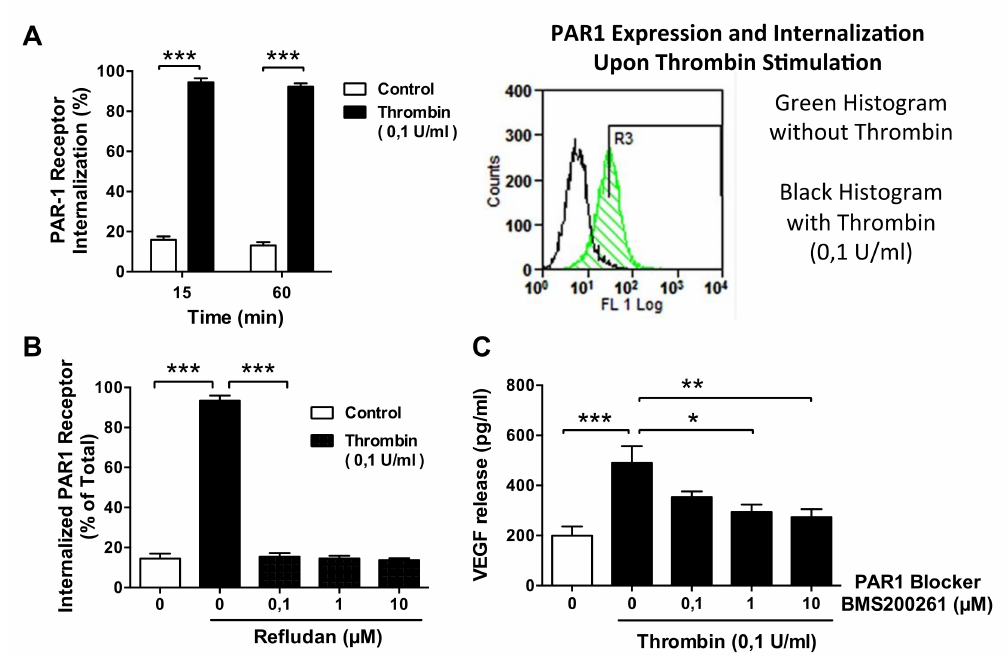
Figure 6. Effect of thrombin on PAR1 receptor in microvascular ECs. ( A ) Percent internalization of activated (cleaved) PAR-1 receptor by HMECs stimulated with or without thrombin (0.1 U/mL) for up to 60 min ( n = 4) with a representative histogram of PAR-1 expression/internalization on HMECs labeled with SPAN12 antibody, stimulated for 15 min with (black) or without (green) thrombin (0.1 U/mL). ( B ) Expression of PAR-1 receptor by HMECs pretreated for 1 h with or without the thrombin inhibitor Refludan and stimulated with thrombin (0.1 U/mL) for 15 min ( n = 4). ( C ) VEGF release in response to thrombin (0.1 pg/mL) by HMECs incubated in the presence of a PAR1 inhibitor, BMS200261, for 24 h, n = 10. ANOVA mean +/ − SEM with * p < 0.05, ** p < 0.01, and *** p <